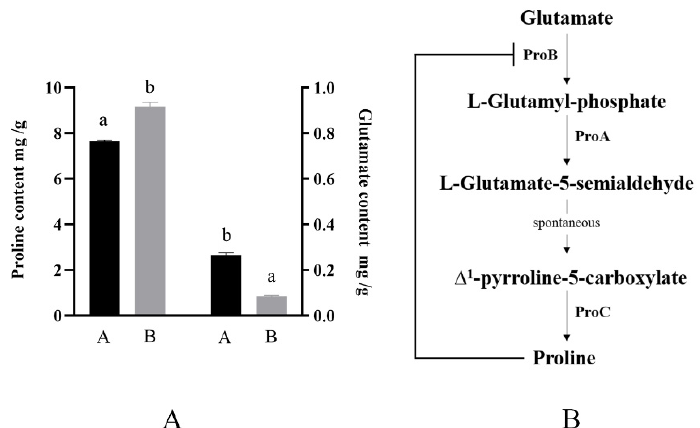
Figure 4. Proline synthesis mode and intracellular proline and glutamic acid contents under different culture conditions. ( A ), B. longum CCFM 1029 intracellular glutamate and proline content under different culture conditions. A is the common osmotic pressure culture group with the addition of 21 g/L proline; B is higher osmotic pressure culture group supplemented with 21 g/L proline. Columns with different letters indicate significant differences ( p < 0.05). ( B ), B. longum CCFM 1029 intracellular proline synthesis process.